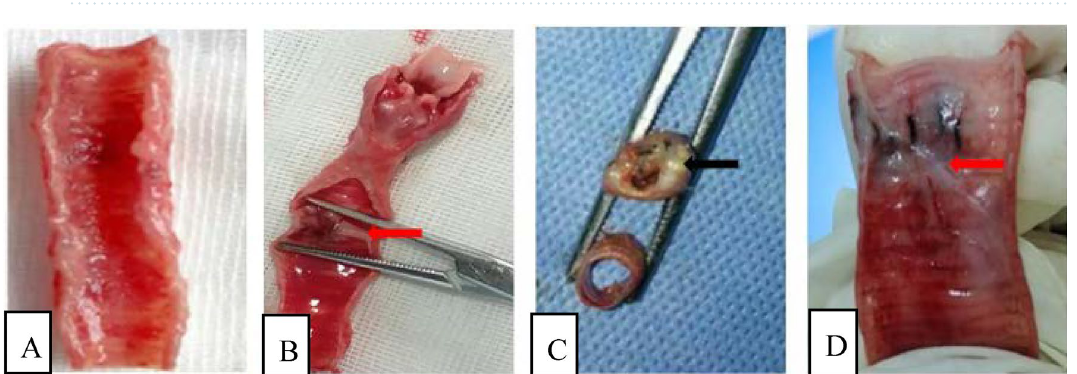
Figure 3. Examination of a gross specimen. ( A–D ) The gross anatomy of experimental rabbits in Groups A, B, C, and D, respectively. Images ( B,D ) shows scar contracture (red arrow); Image ( C ) show granulation tissue proliferating (black arrow) with yellowish-white secretions attached to the